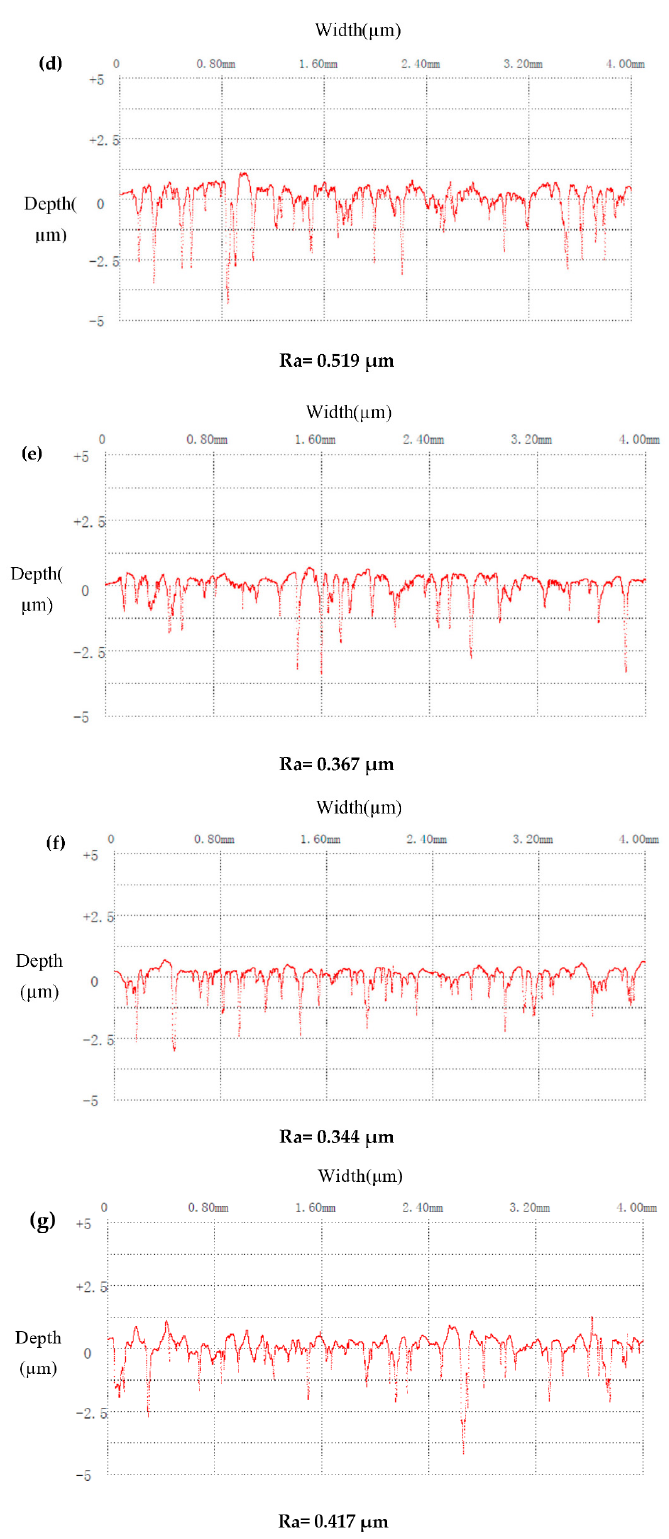
Figure 6. Variations in the contour profiles and surface roughness of cylinder liners lubricated by different oils. ( a ) Initial, ( b ) FFEO, ( c ) EBF, ( d ) 20 vol% EBF, ( e ) 40 vol% EBF, ( f ) 60 vol% EBF, ( g ) 80 vol% EBF.